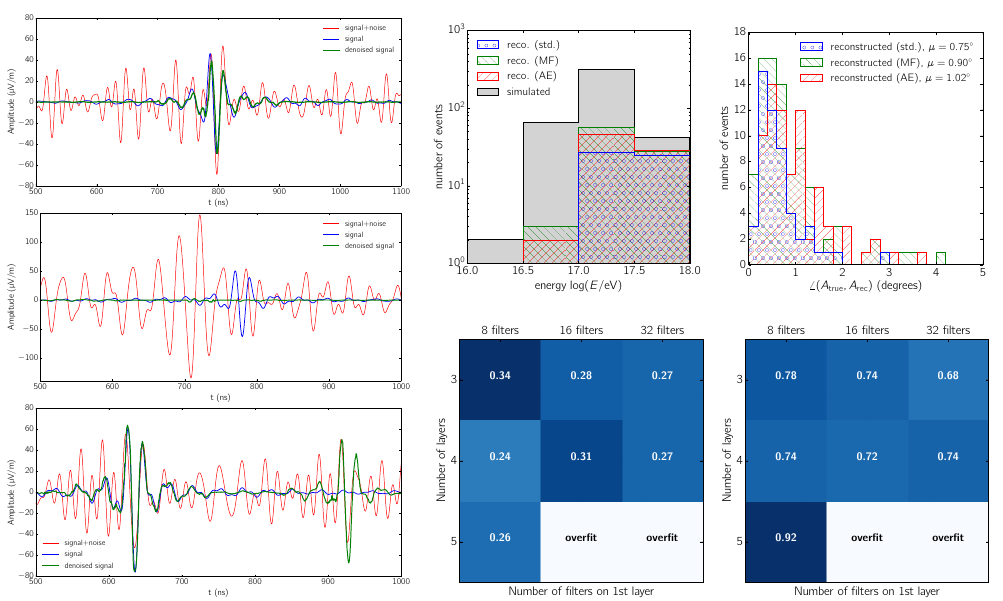
Figure 1. Left panel, examples of AE performance: correct identification (true positive), no identification (true negative), double identification (true plus false positive). Right panel, from the left upper conner to the bottom right: 1) distribution of reconstructed events as function of energy; 2) angular resolution of di ff erent methods; 3) e ffi ciency of AE; 4) purity of